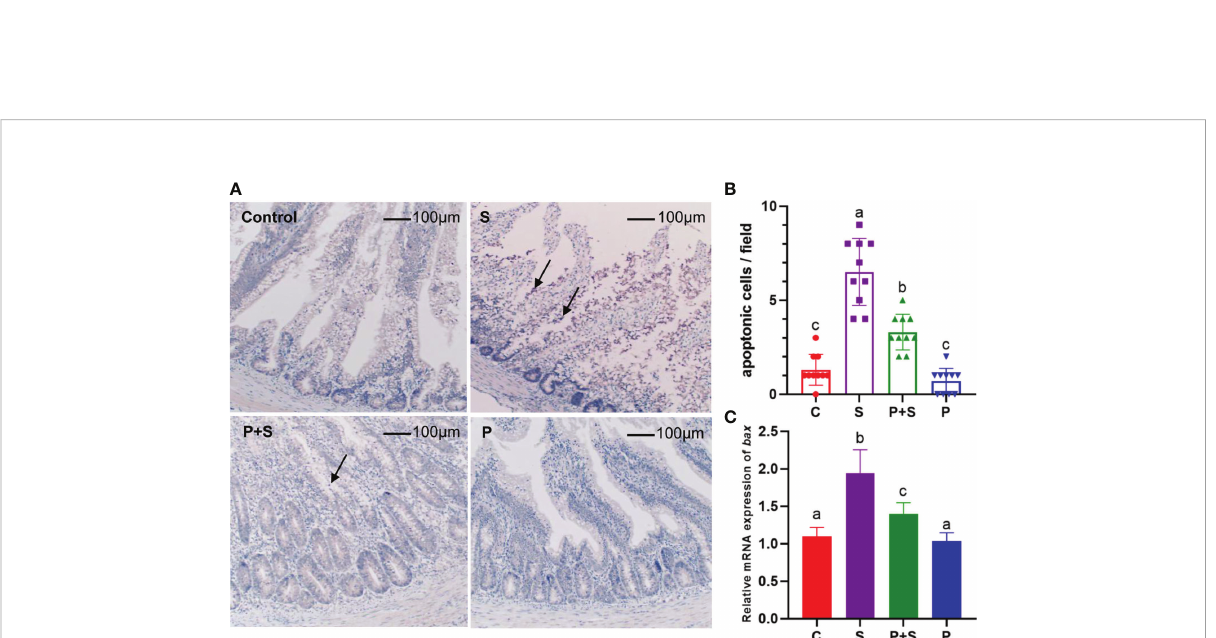
FIGURE 6 Immunohistochemical staining sections of apoptosis-related proteins and the relative gene expression. (A) Immunohistochemical staining was used to identify the existence of apoptosis in intestinal tissue, the arrow points to a brown-stained apoptotic protein aggregation region. (B) The average number of apoptotic cells was counted in each fi eld. (C) RT-qPCR was used to detect the relative mRNA expression of gene Bax . a, b, c: indicated the signi fi cant differences among groups ( P